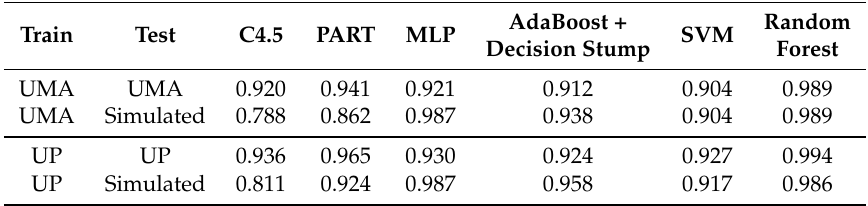
Table 2. Area Under ROC (AUC) evaluation for the binary falls classification. The training was executed using datasets from other works while the testing was against our simulated dataset or if against themselves, using cross-validation with 10